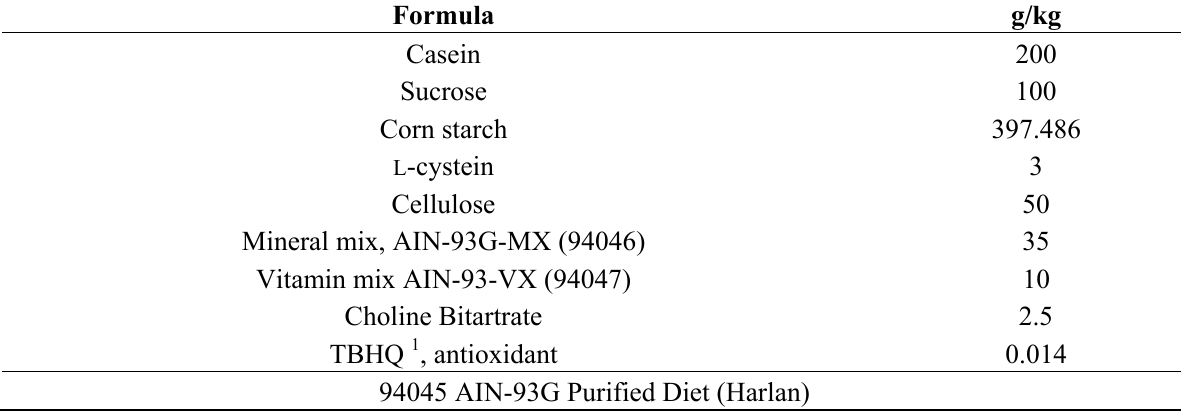
Table 2. Composition of experimental diets (in g/kg diet).